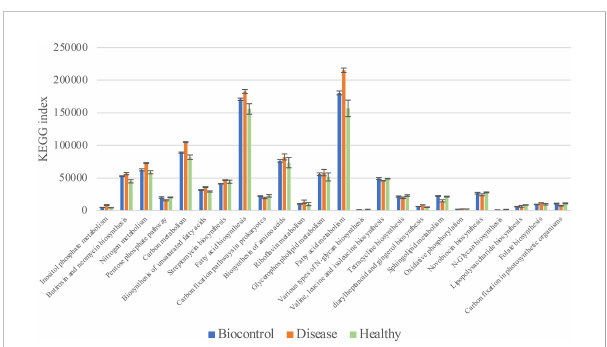
FIGURE 6 KEGG based bar plot generated by PICRUSt2 indicating signi fi cant differences between group D and groups B, H. Green representing the Biocontrol group, red representing the Disease group and blue representing the Healthy group. All the terms listed in the fi gure have signi fi cant difference (Tukey ’ s test) between group D and B or H.